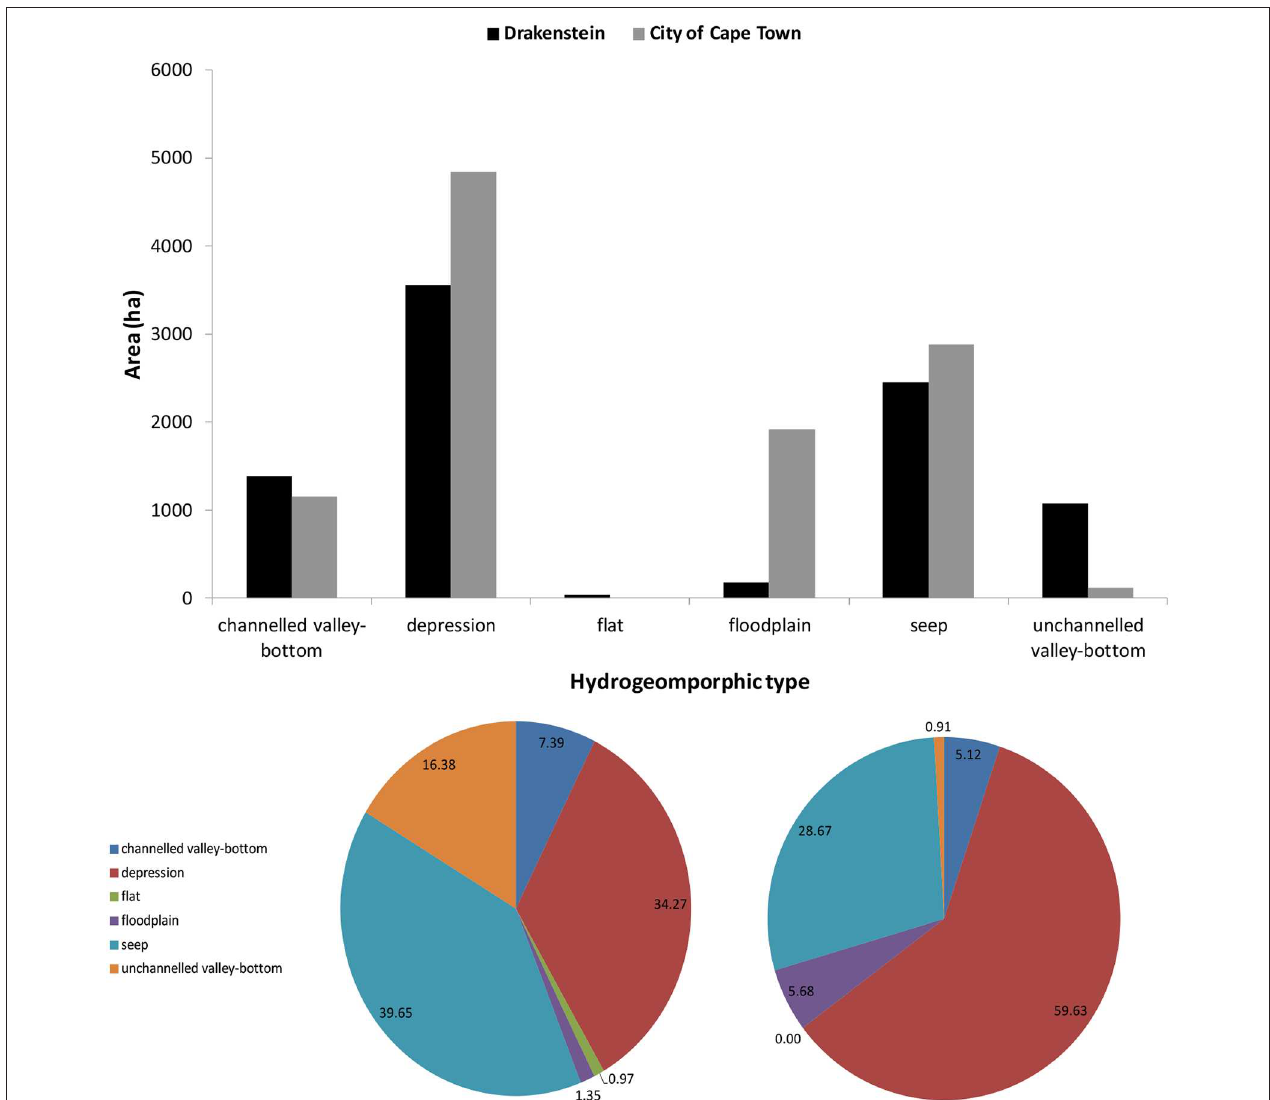
FIGURE 2 | Total area (ha) of wetlands by HGM type (top) and proportion of wetlands by HGM type for the Drakenstein (bottom left) and CoCT (bottom right) regions.